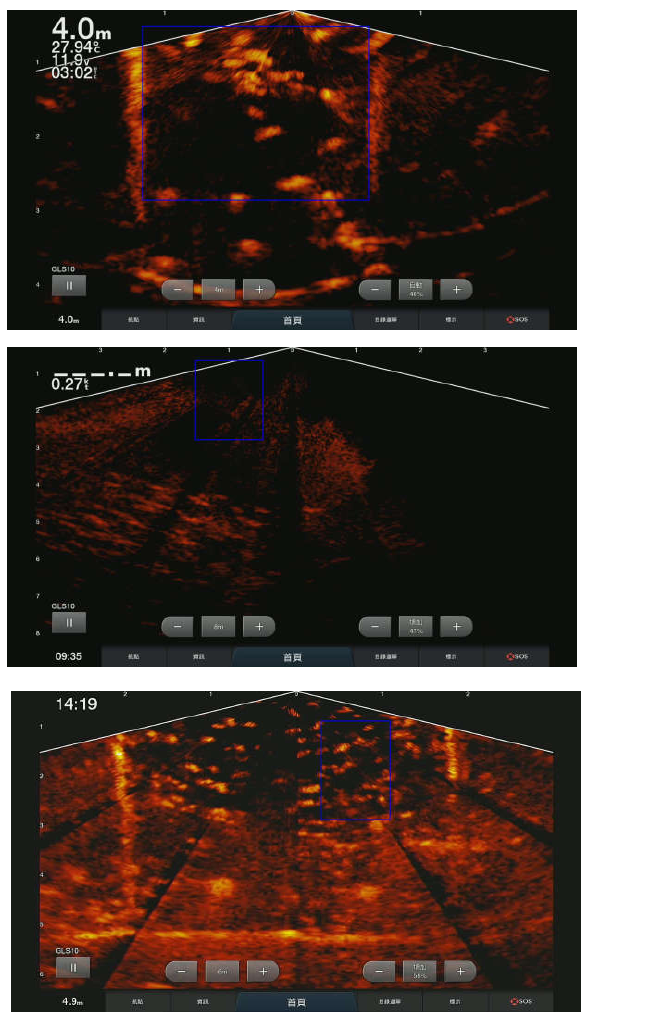
Table 1. The true positive rate of Mask R-CNN for different experimental